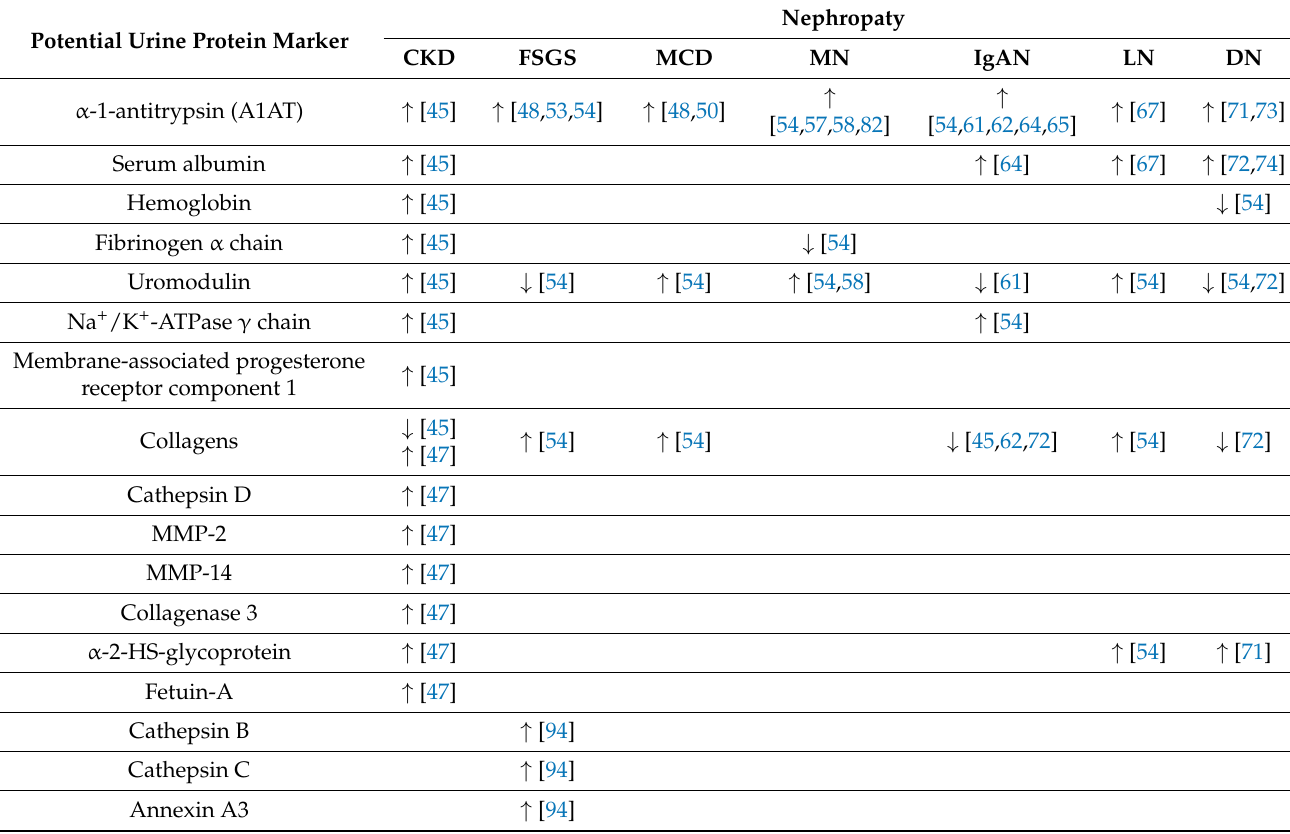
Table 2. Potential urine proteome markers in different